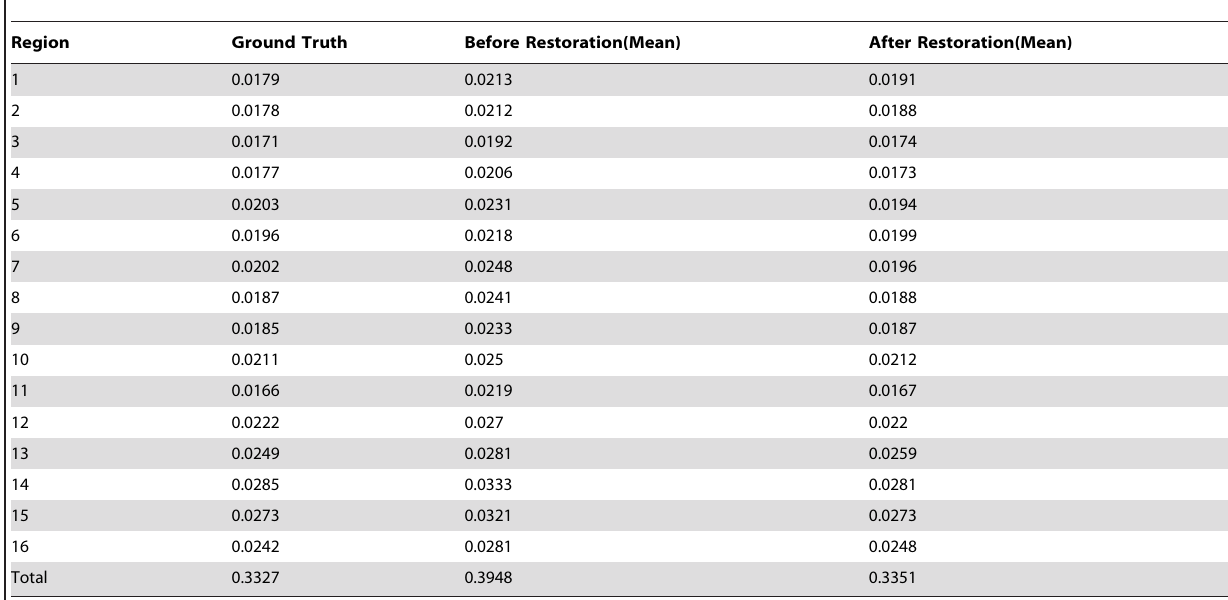
Table 3. Curvedness Values of Ground Truth and Mean Curvedness Values of 30 Samples before and after Restoration over 16 Regions.